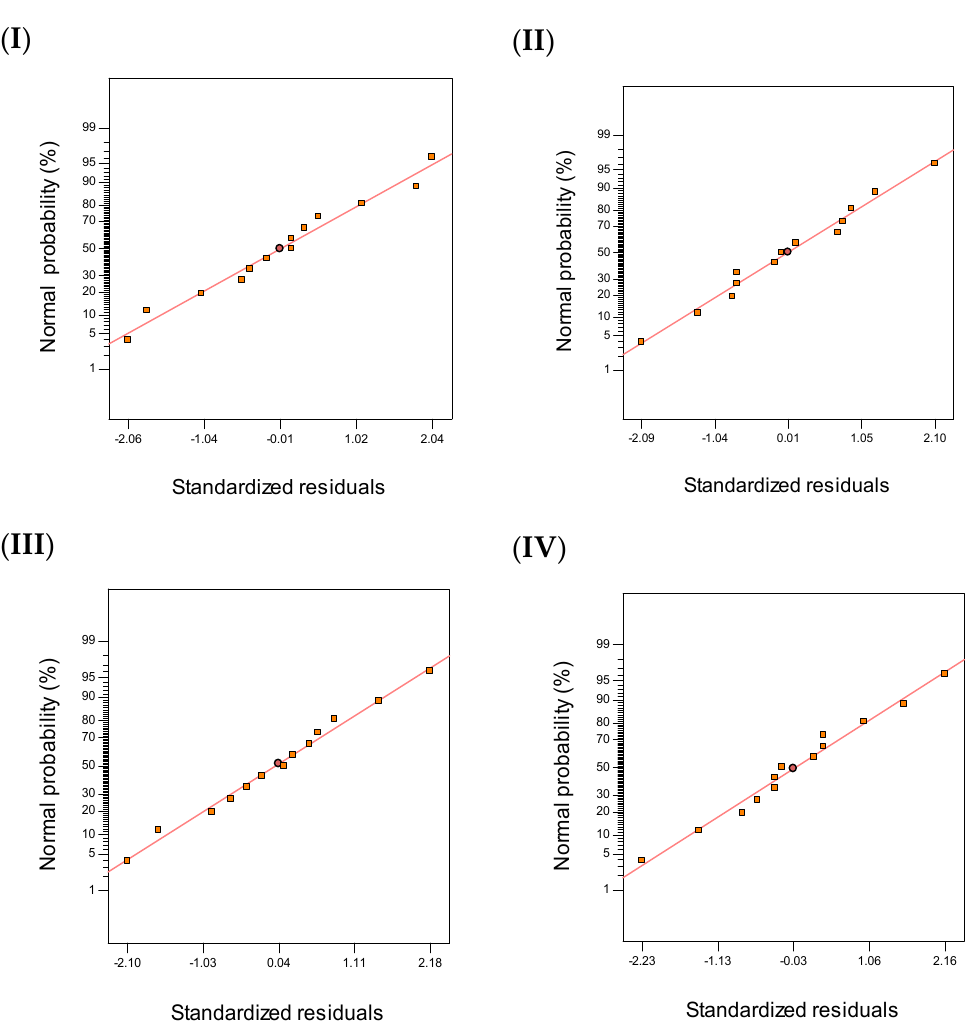
Figure 5. Normalprobabilityplotsfor( I )COD,( II )color, ( III )NH 3 –Nand( IV Figure 5. Normal probability plots for ( I ) COD, ( II ) color, ( III ) NH 3 –N and ( IV ) TSS removals from leachate.